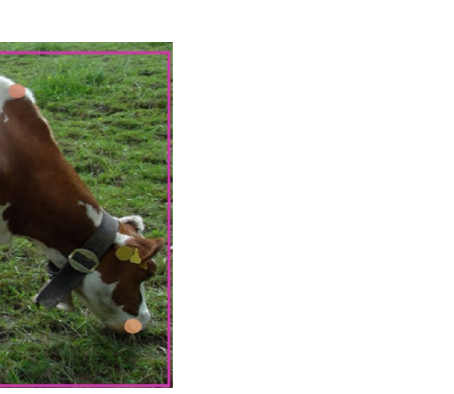
Figure 7. Visual description of the 15 anatomical key points, nose, head, scapula, withers, centre of the back, hook bone, tail setting, all four knees and all four hooves, used as the annotations to train the deep learning